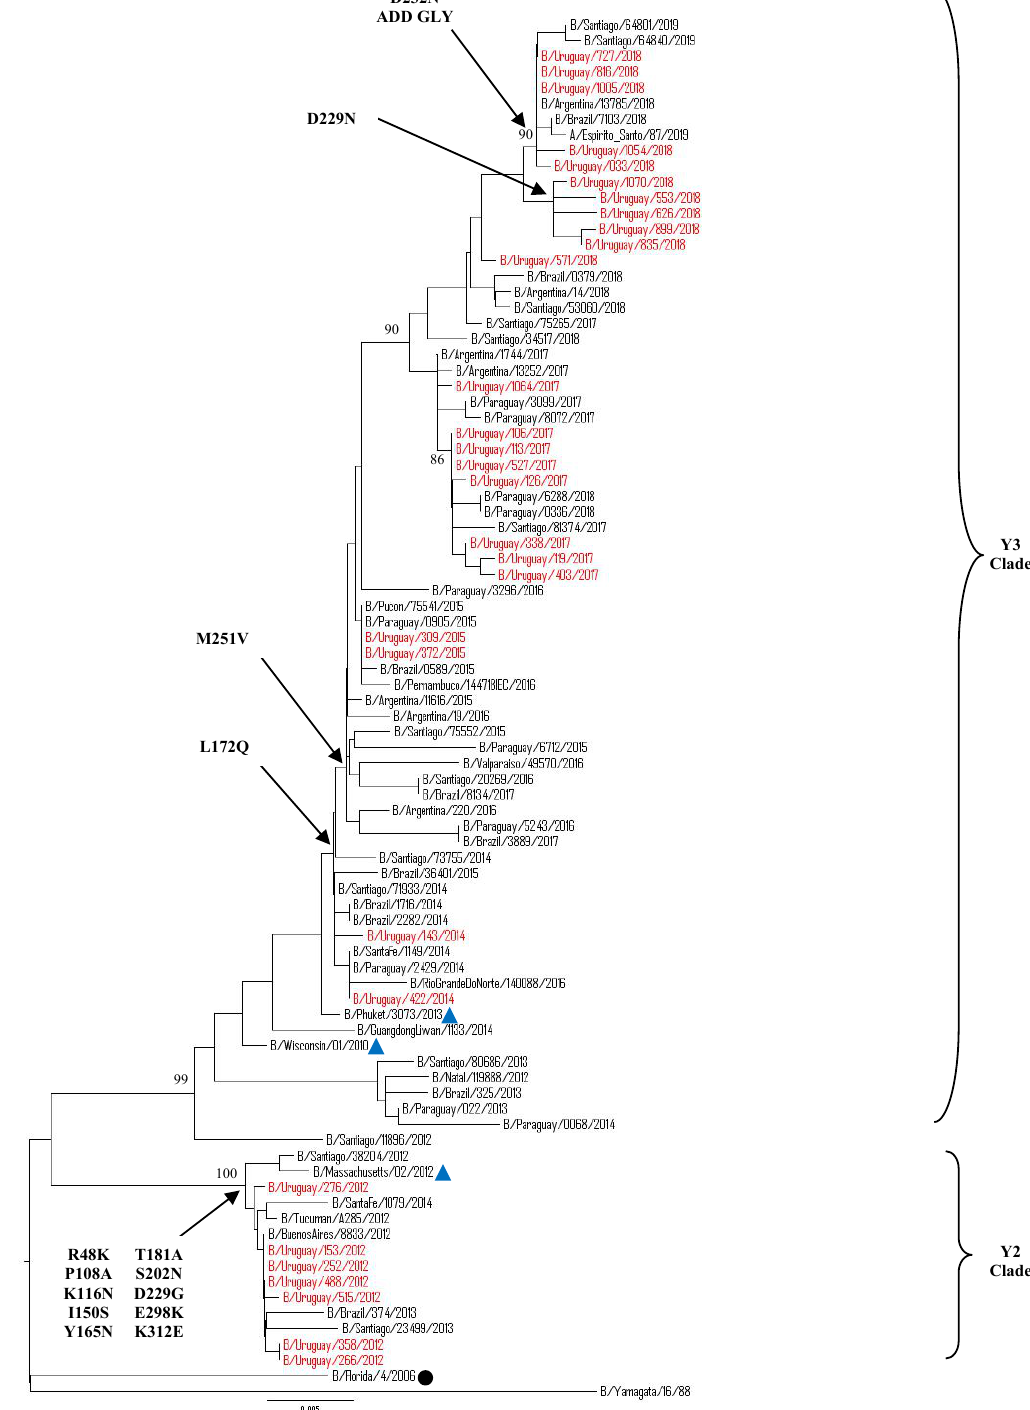
Figure 5. Phylogenetic analysis of HA1 nucleotide sequences from influenza B Yamagata-lineage viruses circulating in Uruguay from 2012 to 2019. The phylogeny tree was generated by the neighbour-joining method with1000 bootstrap replicates. Bootstrap values > 70 are shown in the nodes. Vaccine strains are shown with a blue triangle. Uruguayan strains are shown in red while representative clade strains are indicated with a black circle as a symbol. The scale bar indicates the substitutions per site. The most relevant amino acid substitutions found are indicated with arrows.